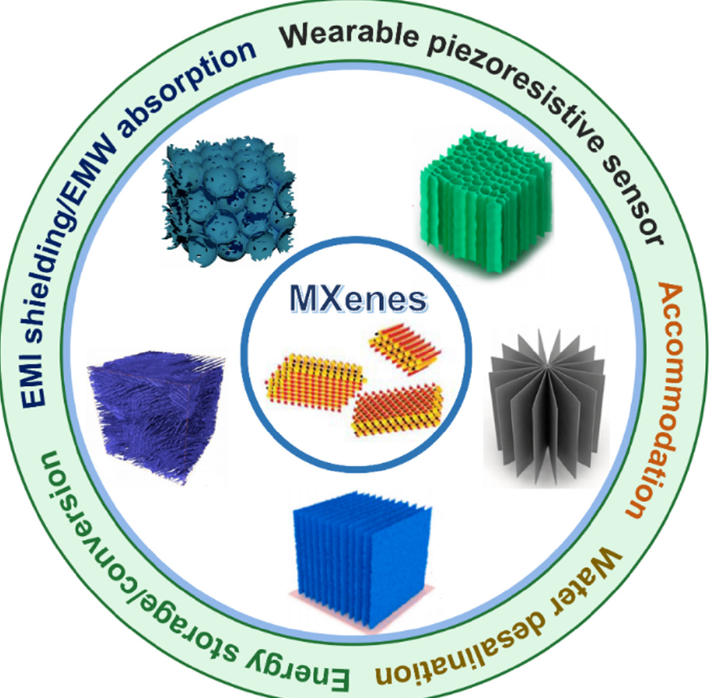
Figure 2. MXene-based porous monoliths: types and applications. Reproduced with permission